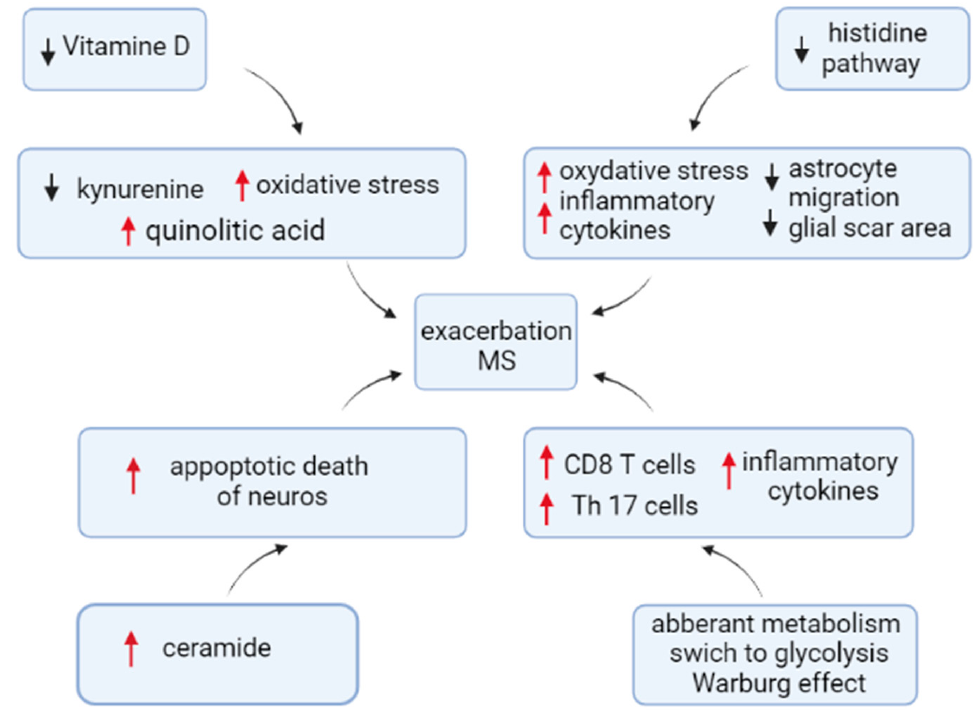
Figure 10. Contribution of metabolites to MS pathogenesis. Our data support the hypothesis of multifactorial pathogenesis of MS. Multiple metabolites were found affected in MS. These metabolites could contribute to oxidative stress, apoptotic death of neurons, astrocyte migration, and scar formation. In addition, affected metabolites could contribute to the activation of pro-inflammatory cytokine production and differentiation of pathogenic CD8+ and Th17 lymphocytes. Additionally, affected metabolites indicate changes in cell metabolism, which could support the differentiation of CD8+ cells.